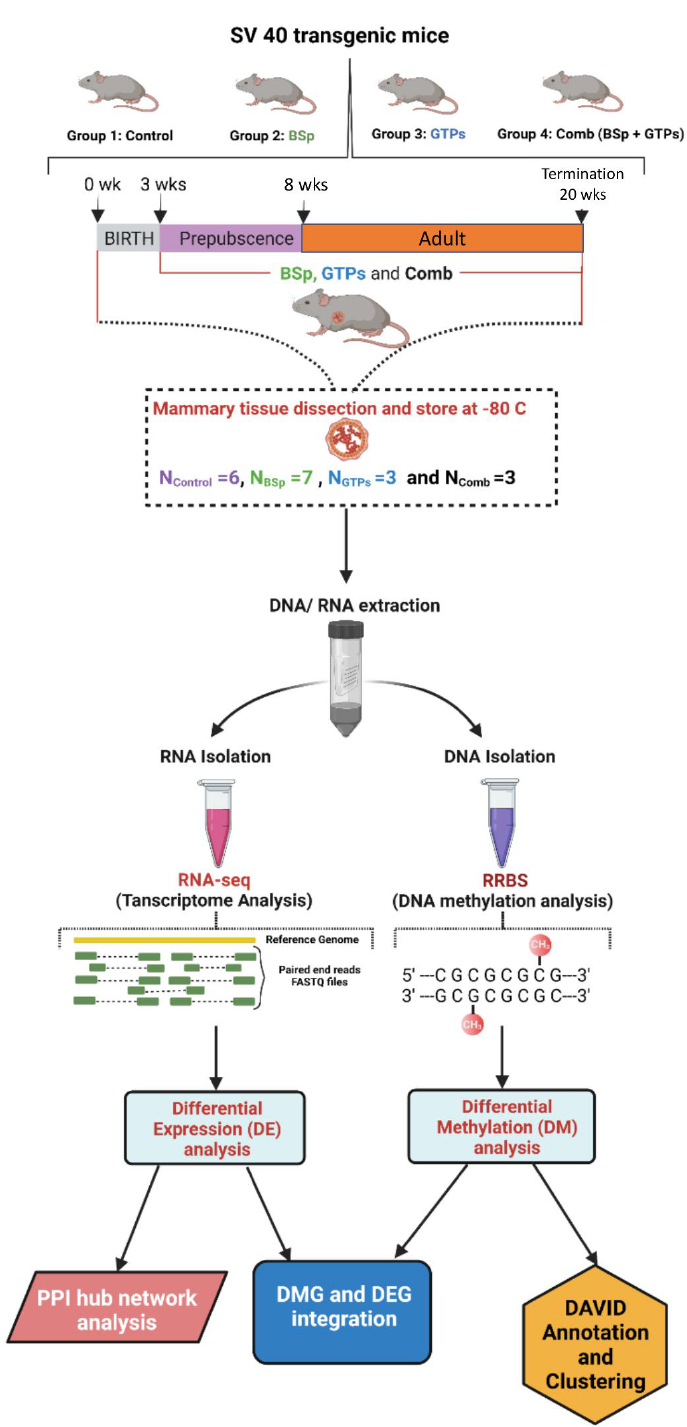
Figure 1. Study Design. An overview of framework demonstrates experimental design and data analysis pipeline. Dietary treatment across different groups (Group 1: control; Group 2: BSp; Group 3: GTPs and Group 4: combination (BSp + GTPs) started at 3 wks of age and mice were euthanized at 20 wks when all mice in the control group developed mammary tumors. RNA and DNA were extracted from the harvested mammary tumors, and then RNA-seq and RRBS libraries were constructed to obtain transcriptome and DNA methylome, respectively. Disease and functional pathways were generated using DAVID, gene ontology (GO) functional annotation based on the DEGs and DMGs, respectively. This figure was created using BioRender (https://biorender.com, accessed on 13 November